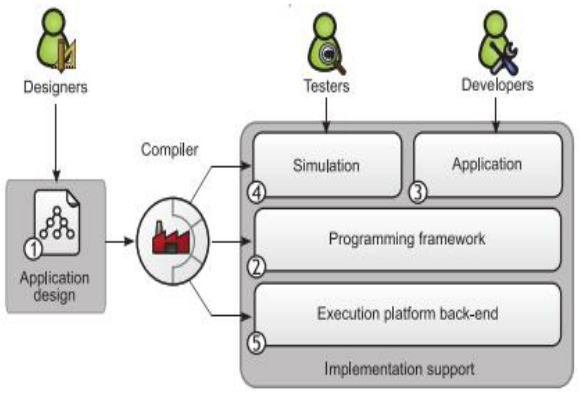
Fig. 4. The DiaSuite tool-based methodology [73]